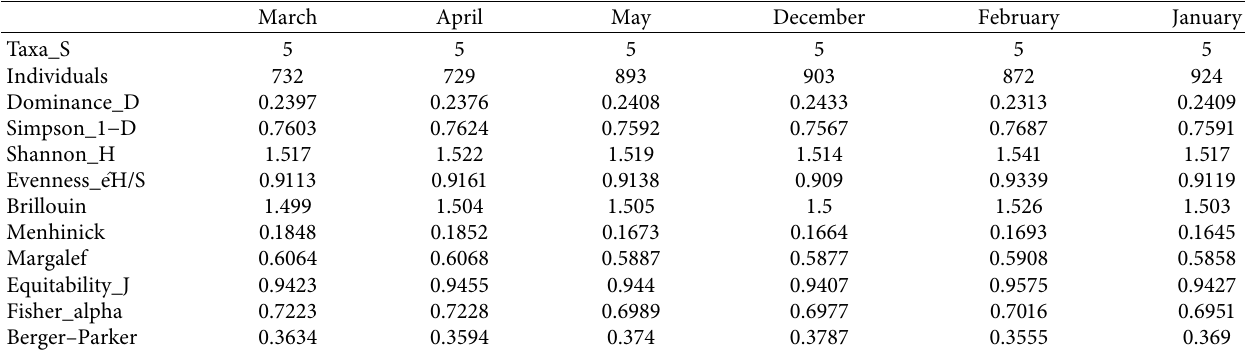
Table 4: Diversity indices of Anopheles mosquito larvae across the season